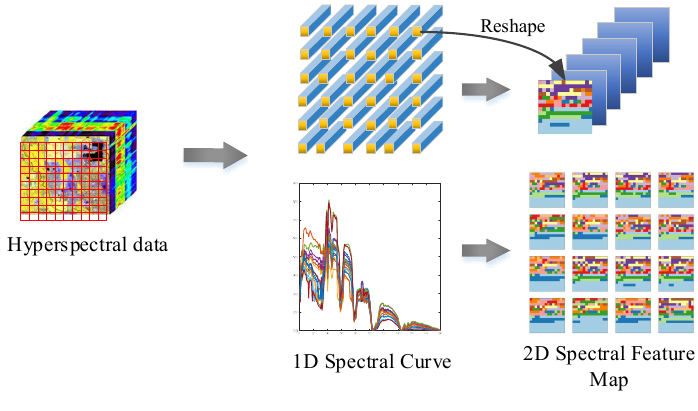
Figure 1. The diagram of data pre-processing procedure.